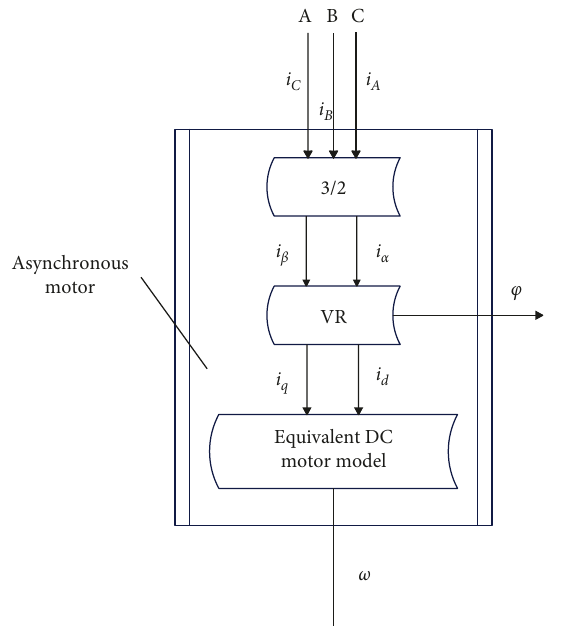
Figure 1: Coordinate transformation structure diagram of